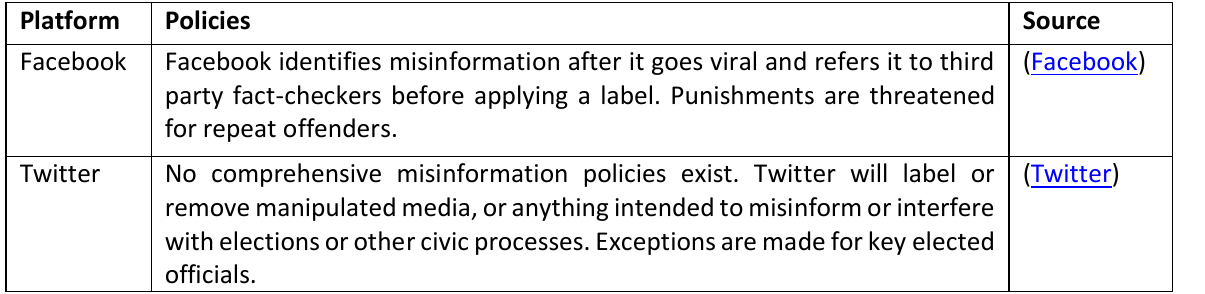
Table 2 . Summary of social media fact-checking